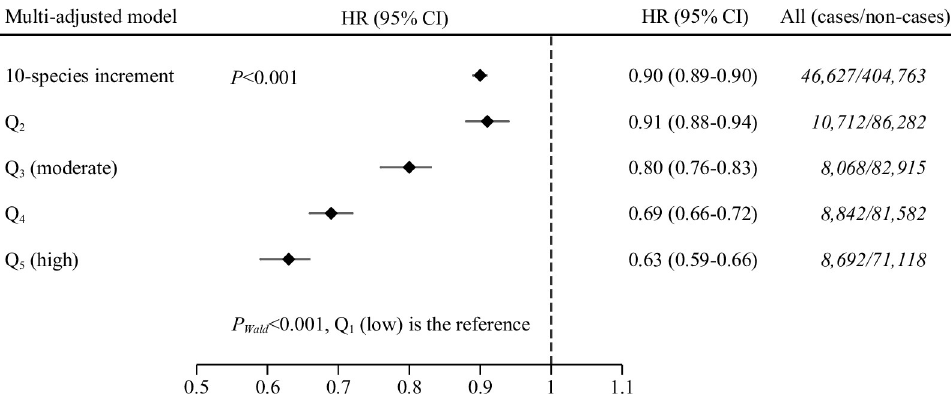
Fig 2. Inverse association between higher DSR per year and total mortality rate in the EPIC cohort, 1992 to 2014. Multiadjusted models were stratified for center, age at recruitment (1-year intervals, timescale), and sex and adjusted for baseline alcohol intake (g/day), physical activity (Cambridge index: active; moderately active; moderately inactive; inactive; missing), marital status (single, divorced, separated, or widowed; married or living together; unknown), smoking status and intensity of smoking (current, 1 to 15 cigarettes/day; current, 16 to 25 cigarettes/day; current, 26+ cigarettes/ day; current, pipe/cigar/occasional; current/former, missing; former, quit 11 to 20 years; former, quit 20+ years; former, quit � 10 years; never; unknown), educational level [longer education (including university degree, technical or professional school); secondary school; primary school completed; not specified], baseline energy intake (kcal/day), baseline fiber intake (g/day), baseline red and processed meat consumption (g/day), and an 18-point Mediterranean diet score [49]. P -values remained statistically significant after adjustment for multiple testing using the Benjamini–Hochberg method. CI, confidence interval; DSR, dietary species richness; EPIC, European Prospective Investigation into Cancer and Nutrition; HR, hazard ratio; Q, quintile.